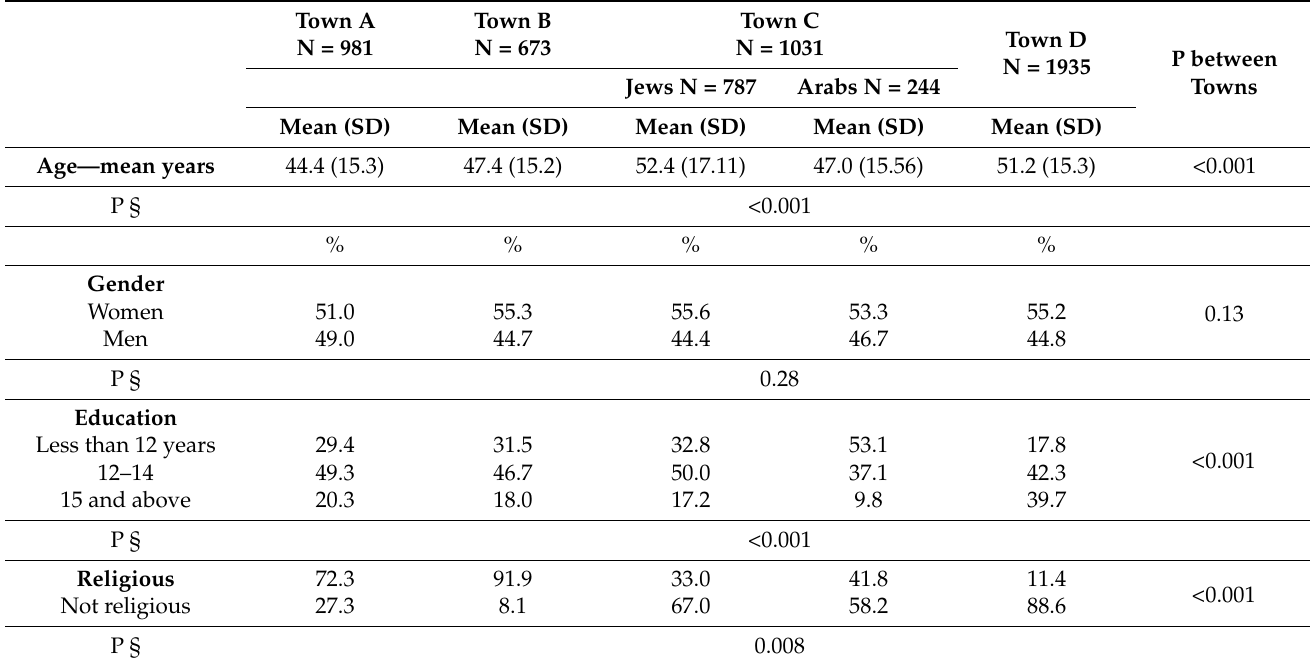
Table 1. Selected characteristics of the study in each town, mean, standard deviation (SD) or percent and